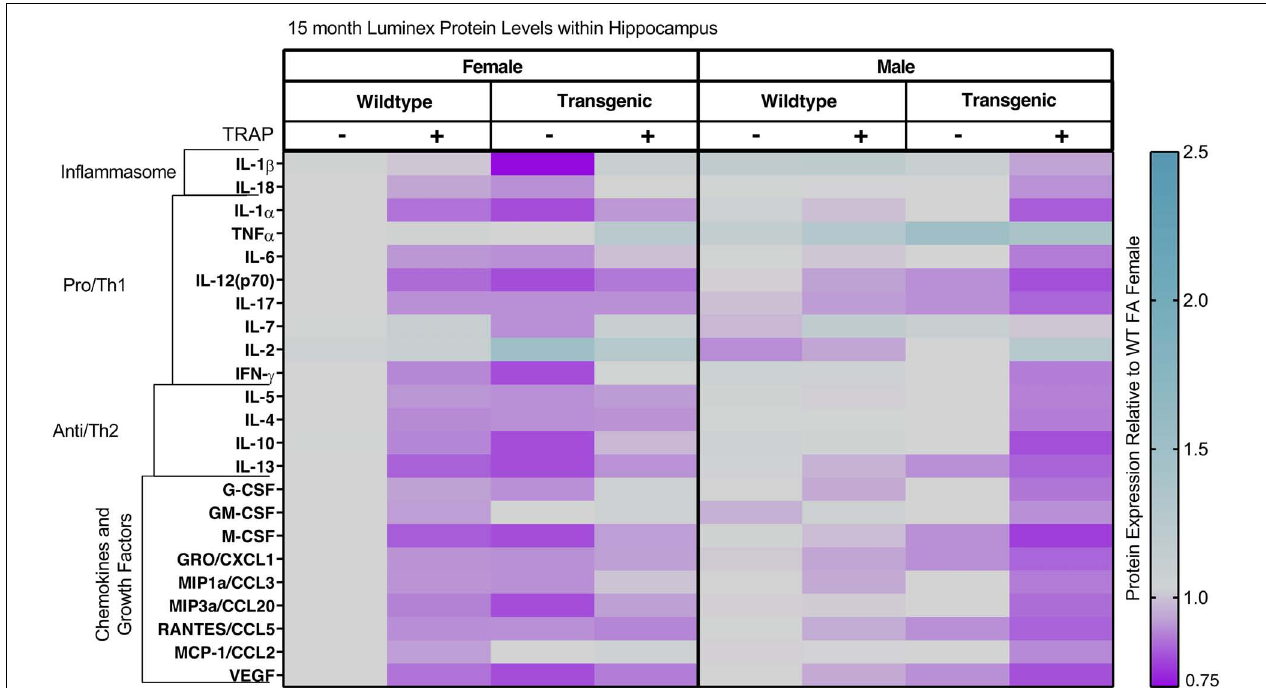
FIGURE 9 | Heat map representation of hippocampal cytokine, chemokine, and growth factor changes in response to TRAP in 15-month old TgF344-AD and WT rats. Hippocampal levels of cytokines and growth factors in TgF344-AD and WT rats exposed to FA or TRAP for 14 months were analyzed using multiplex technology. For each analyte, individual values were normalized to the mean level of that same analyte in hippocampal tissue from female FA WT animals. Purple indicates normalized protein levels < 1.0; turquoise indicates normalized protein levels > 1.0. ± indicates exposure with + identifying TRAP-exposed animals; - indicating FA-exposed animals; n = 4–5 animals per group (duplicate samples were analyzed for each animal). Non-normalized cytokine values for female WT animals are provided in Supplementary Table 2